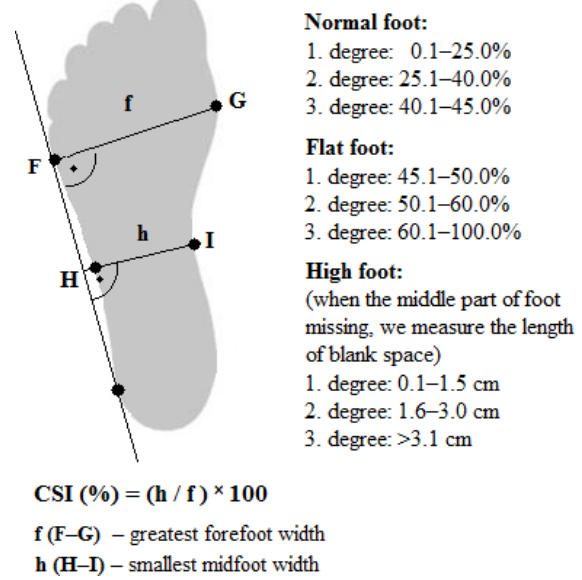
Figure 1. Measured foot